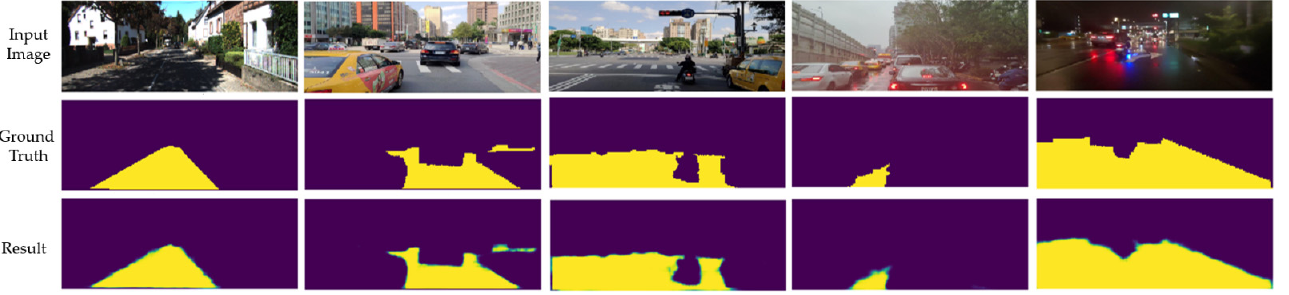
Table 2. Performance of different neural networks using the KITTI road dataset. Max: maximum; Avg: average; PRE: precision; REC: recall.